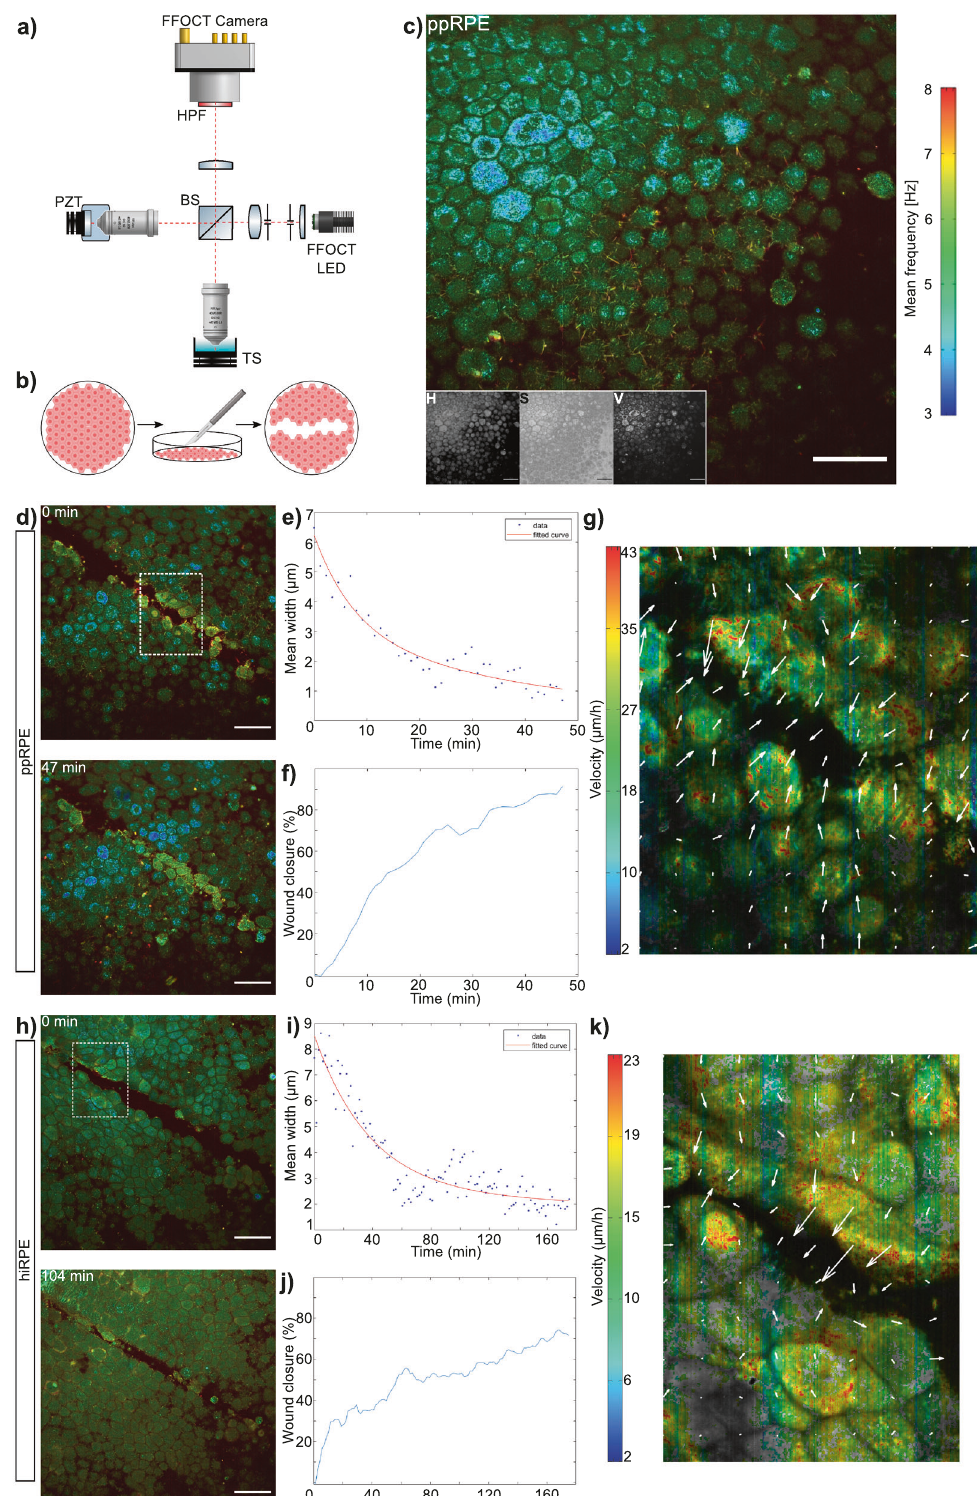
around 55 min, and an average limit of 2.5 μ m was reached after approximately 60 min. The average speed of closing was therefore 6.5 μ m/h. The results of the optical fl ow method are shown in (Fig. 1k), clearly showing two borders which progress in two different directions, but the upper border is more active than the lower (see the aspect of arrows in Fig. 1k. The average speed calculated on the optical fl ow representation was 4.05 μ m/h, and